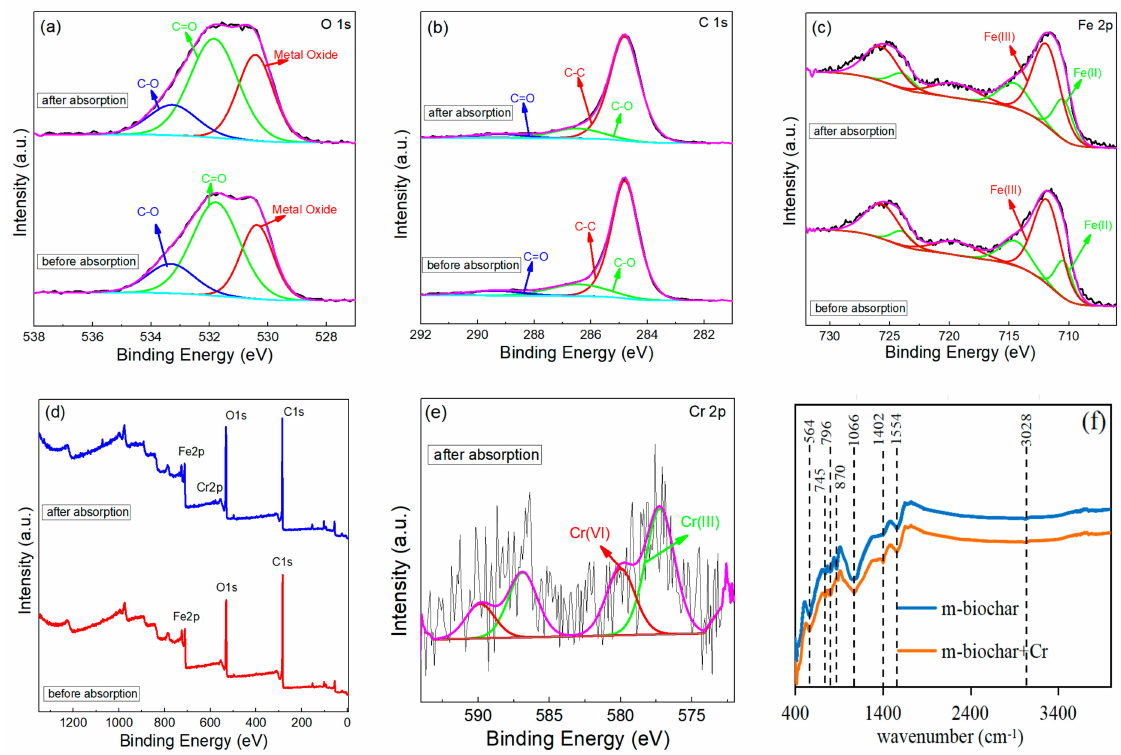
Figure 6. XPS and FTIR spectra of m-biochar before and after Cr(VI) adsorption: the narrow scan of O 1s ( a ), C 1s ( b ), Fe 2p ( c ) spectra, wide-scan survey ( d ), Cr 2p spectra ( e ), and FTIR spectra ( f